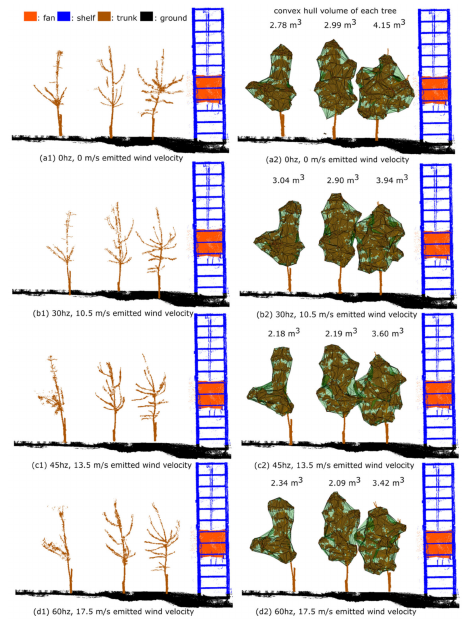
Figure 6. Tree crown volume changes and branch skew variations of the three rubber trees under four wind speeds, i.e., 0 m/s, 10.5 m/s, 13.5 m/s, and 17.5 m/s. ( a1 – d1 ) show only the branch point clouds. ( a2 – d2 ) show the results after calculating the tree crown volumes of the three rubber trees at four wind speeds with the alpha shape